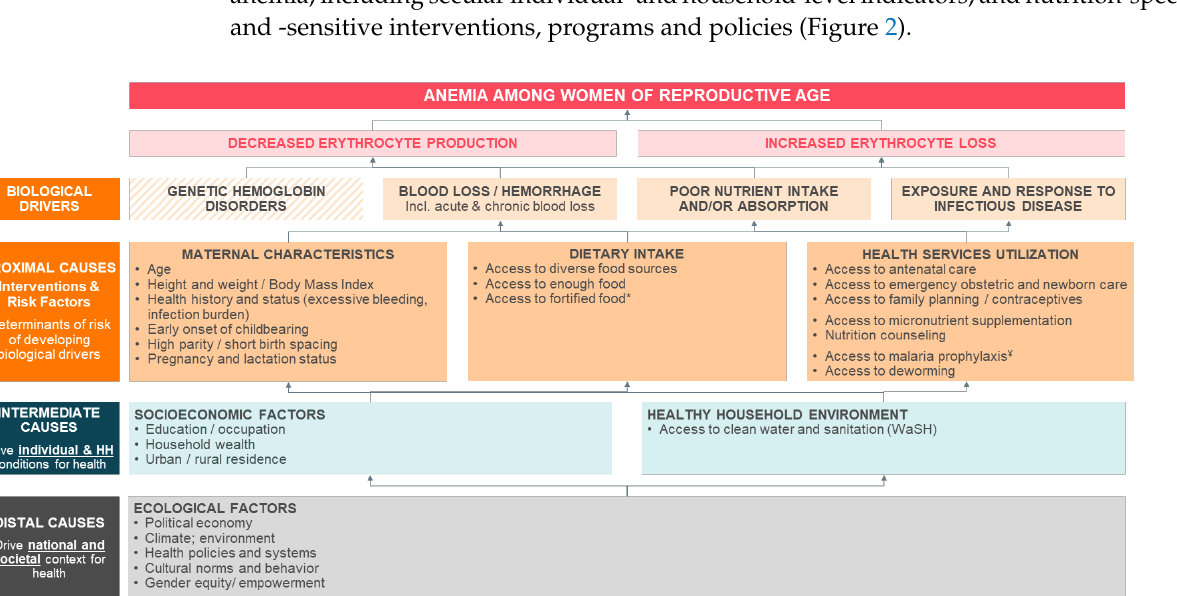
Figure 3. Setting and sample representativeness of included studies. The median methodological quality score was 7 (range: 5.5–8), resulting in eight studies classified as low quality, eight studies [19,24,27,29,30,32,34,36] classified as moderate, and five studies [20,28,33,38,39] classified as high quality. Reduction in WRA anemia varied widely across the included studies, with CAGR ranging from −0.4 to −13.0%, with a median of −3.8%. Three studies carried out regression decomposition analyses of change in WRA anemia prevalence in India (among pregnant women: [33], Tanzania (among non-